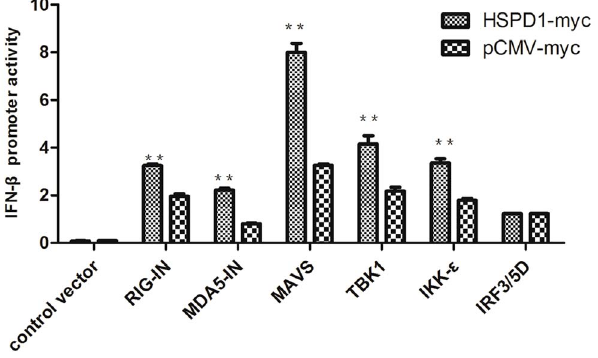
Fig. 5. HSPD1 regulated IFN- b induced by various components of the signaling. HEK293Tcells were co- transfected with the luciferase reporter plasmid pIFN- b -Luc, the Renilla luciferase plasmid phRL-TK, HSPD1 plasmid or control plasmid, and RIG-IN, MDA5-IN, MAVS, TBK1, IKK e , IRF3-5D or control plasmid. At 32 h post-infection, all of the samples were collected and the luciferase activity was measured using a dual- luciferase assay system. Data represent the relative firefly luciferase activity normalized to the Renilla luciferase